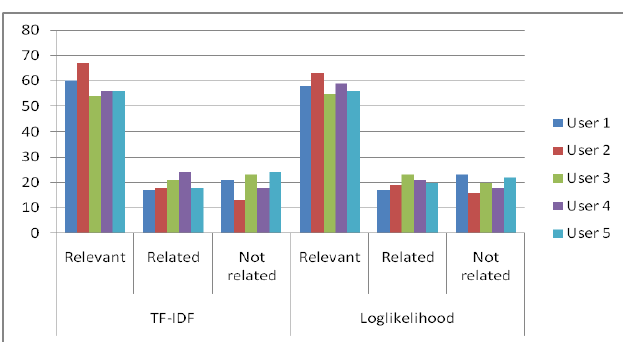
Fig. 1. Relevancy Test based on TF-IDF and Loglikelihood method’s result